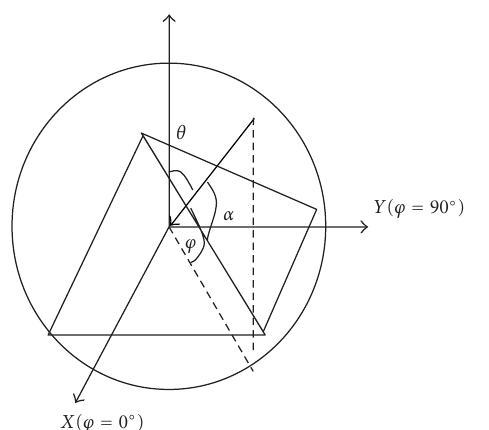
Figure 6: The diagram of a spherical polar coordinate system, which is quantified, is used to describe the surface morphology of the alkaline-etched wafers.